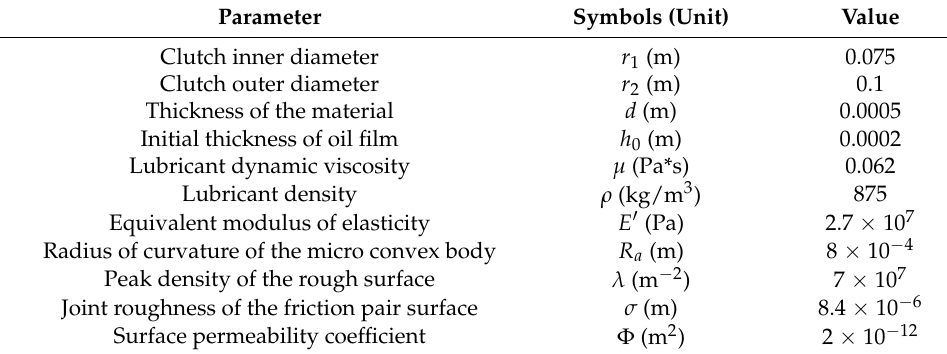
Table 3. Parameters of the wet dual-clutch transmission.